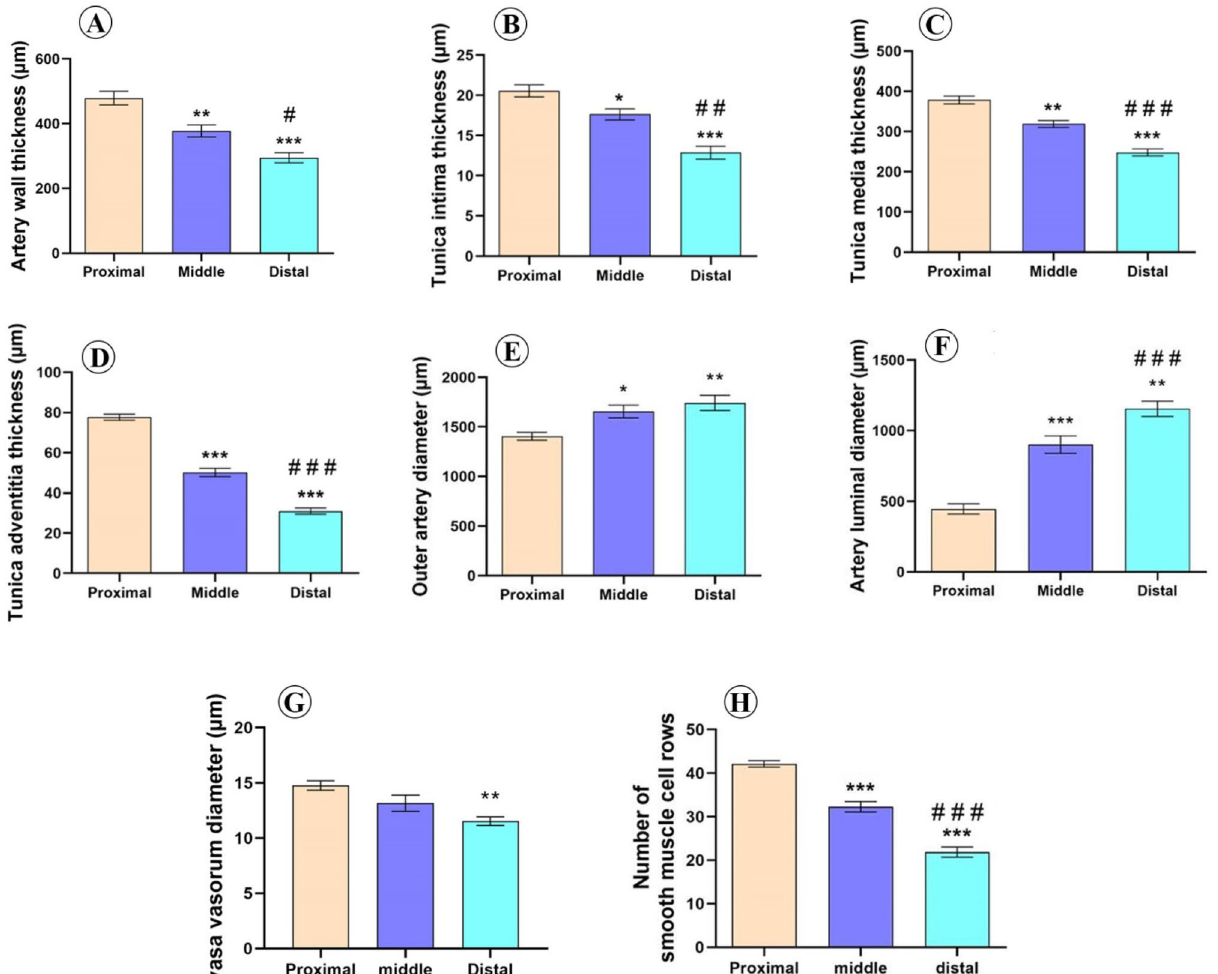
Figure 6. Morphometrical analysis of the testicular wall in proximal, middle, and distal supratesticular zones of the testicular artery in the supratesticular region. ( A ) Artery wall thickness; ( B ) Tunica intima thickness; ( C ) Tunica media thickness; ( D ) Tunica adventitia thickness; ( E ) Outer arterial diameter; ( F ) Inner luminal diameter; ( G ) Vasa vasorum diameter; ( H ) Number of smooth muscle cell rows of tunica media. *p < 0.05, **p < 0.01 and ***p < 0.001 versus proximal zone; # p < 0.05, ## p < 0.01 and ### p < 0.001 versus middle